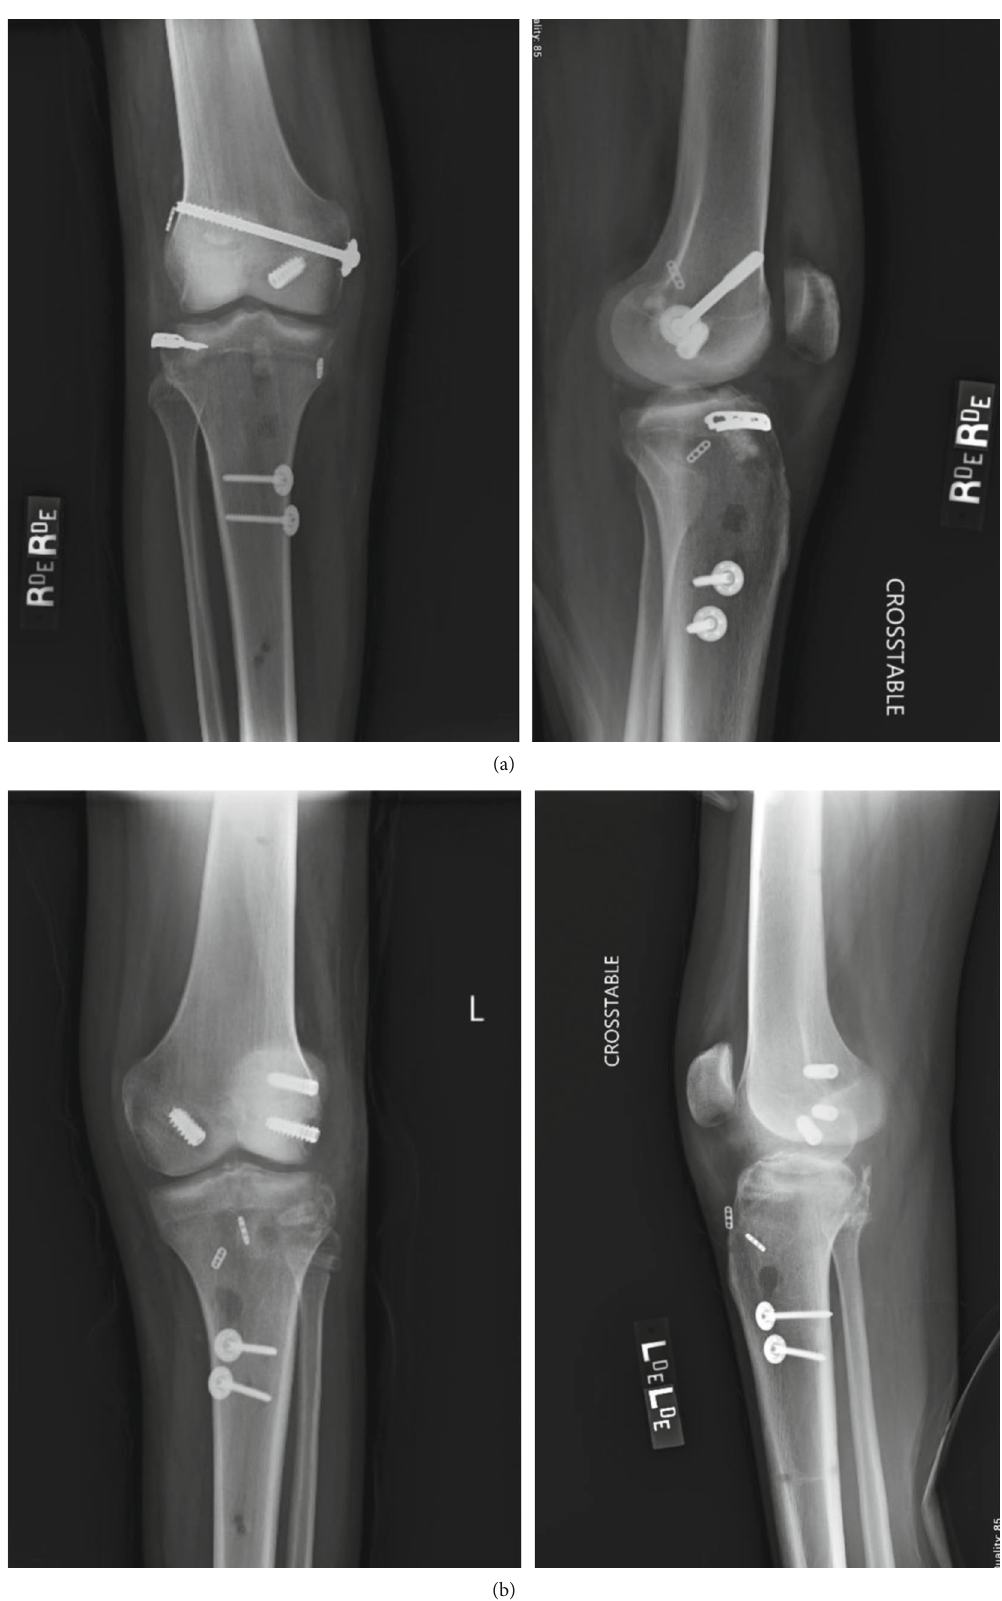
Figure 6: (a) Follow-up X-ray of the right knee. (b) Follow-up X-ray of the left